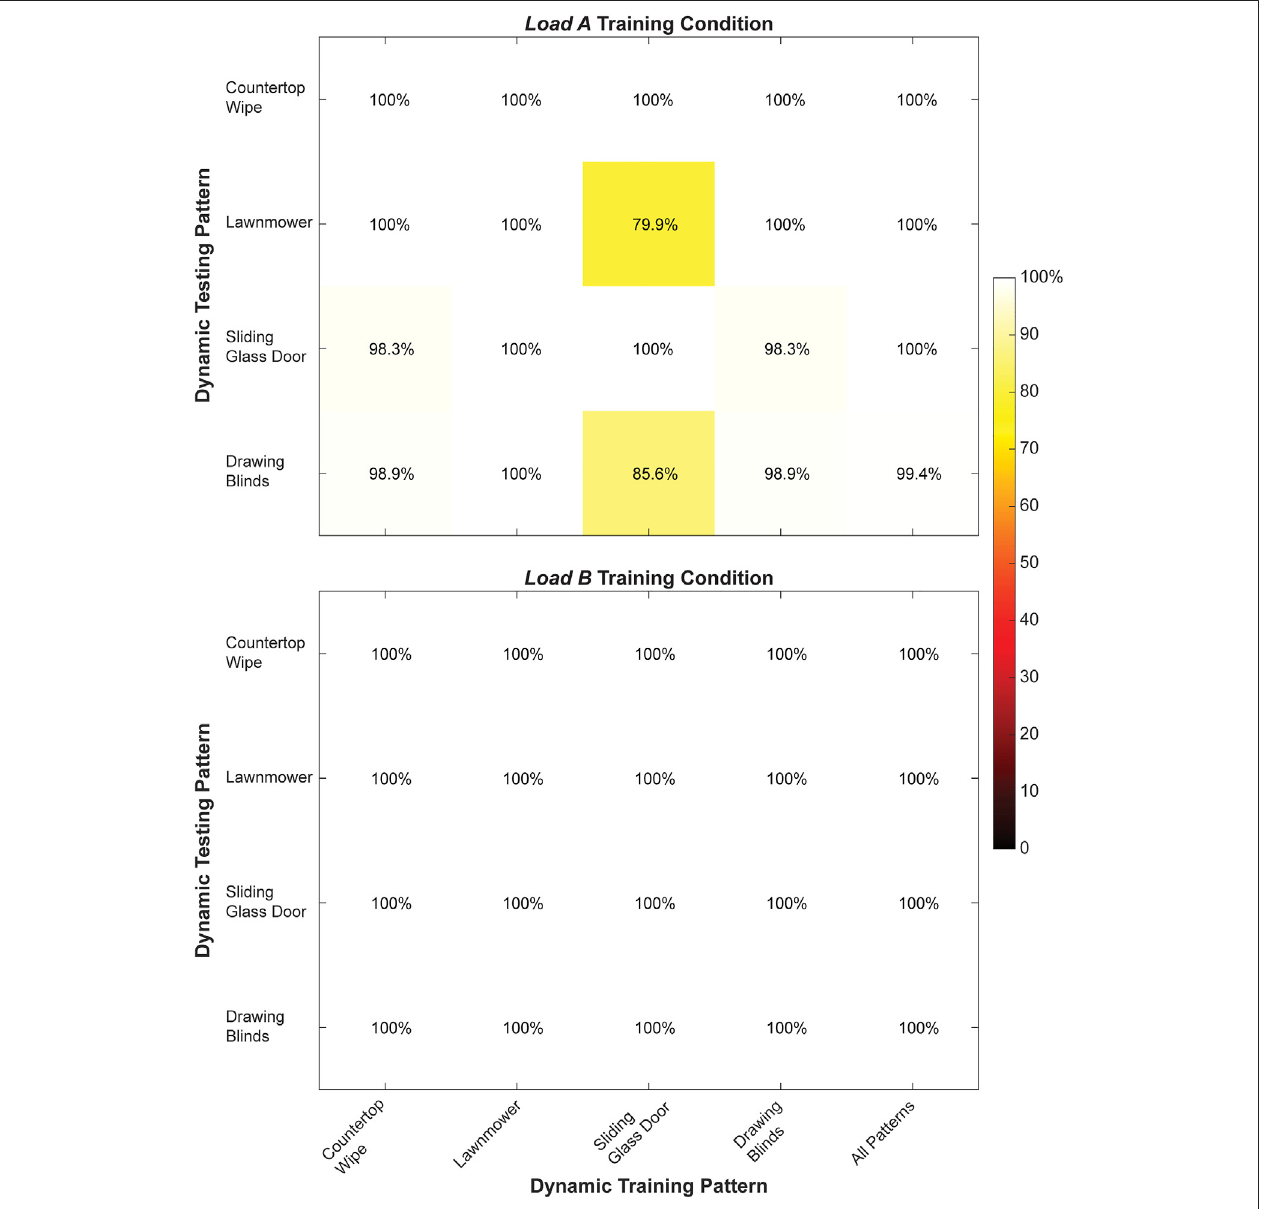
FIGURE 6 | Classi fi cation accuracy (%) for the right arm when training and testing each of the dynamic movement patterns individually and from all dynamic movement patterns collectively during the load A and load B training conditions. Values shown in the main diagonal represent the intrapattern classi fi cation accuracies, while the off-diagonal values represent the interpattern classi fi cation